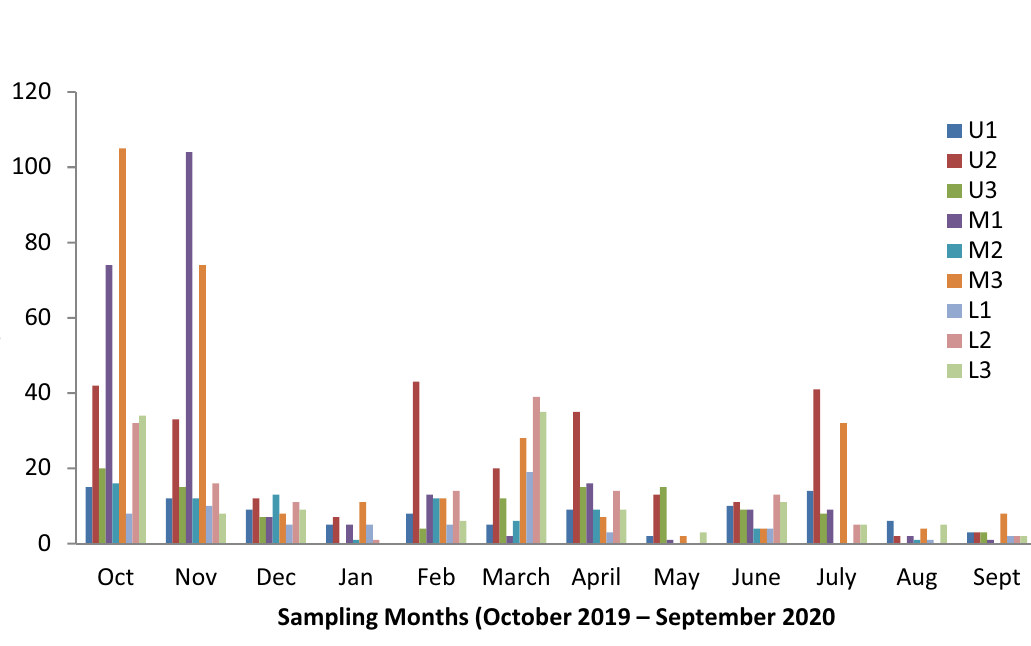
Fig. 3 Monthly variation of E. coli counts across stations during the study period (October 2019–September 2020)